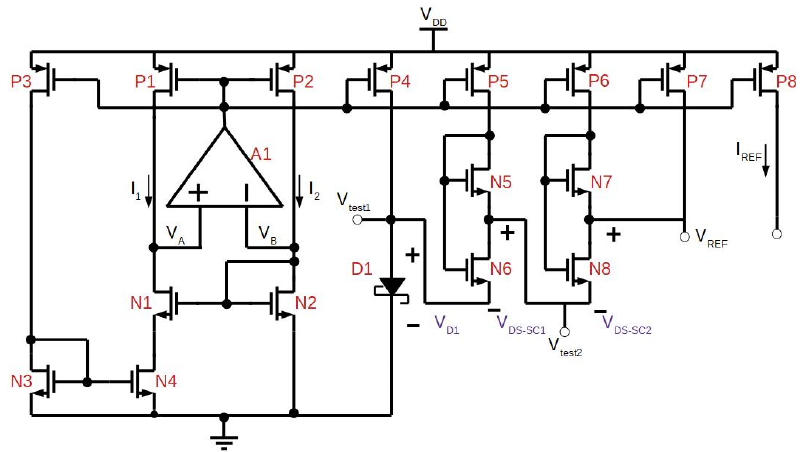
Figure 9. The proposed voltage reference.